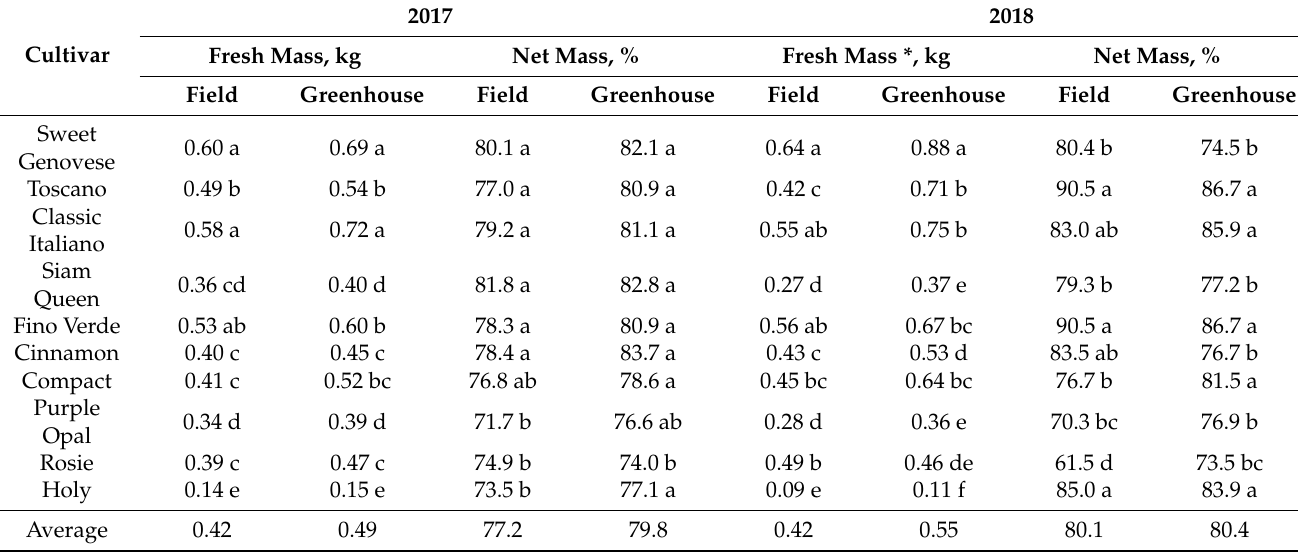
Table 4. Productivity of basils grown in 2017 and